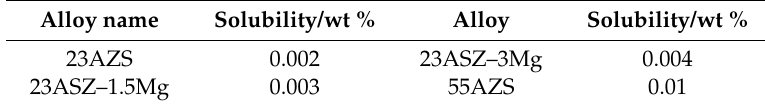
Figure 18. The solubility curves of Fe in different alloys: ( a ) 23AZS– x Mg ally, ( b ) 55AZS alloy. Table 4. The solubility of Fe in different alloys.